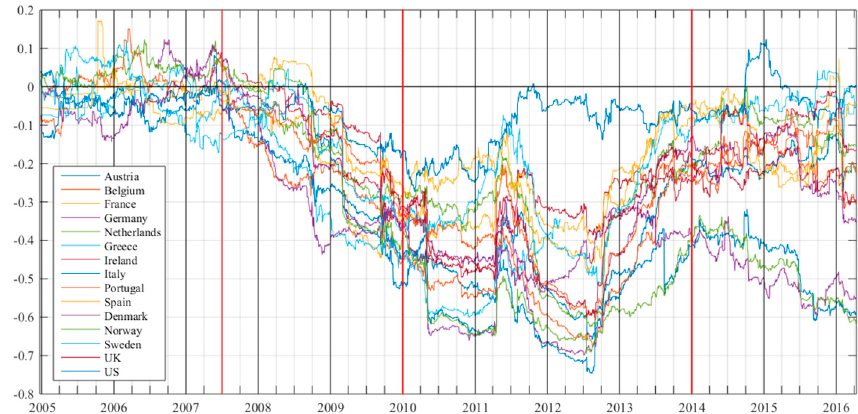
Figure 2. Daily time evolution of the correlation coefficients of the European and US stock indices and sovereign CDS returns using 250-day rolling windows. The sample period is from 6 January 2004 to 12 April 2016. The vertical red lines mark the beginning of the different sub-periods: global financial crisis, Eurozone sovereign debt crisis and post-crisis period.